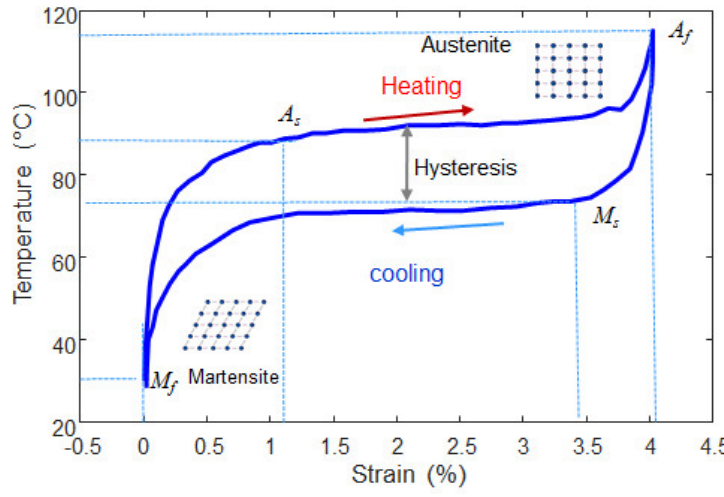
Figure 7. Typical phase transformation curve of SMA wire [35].